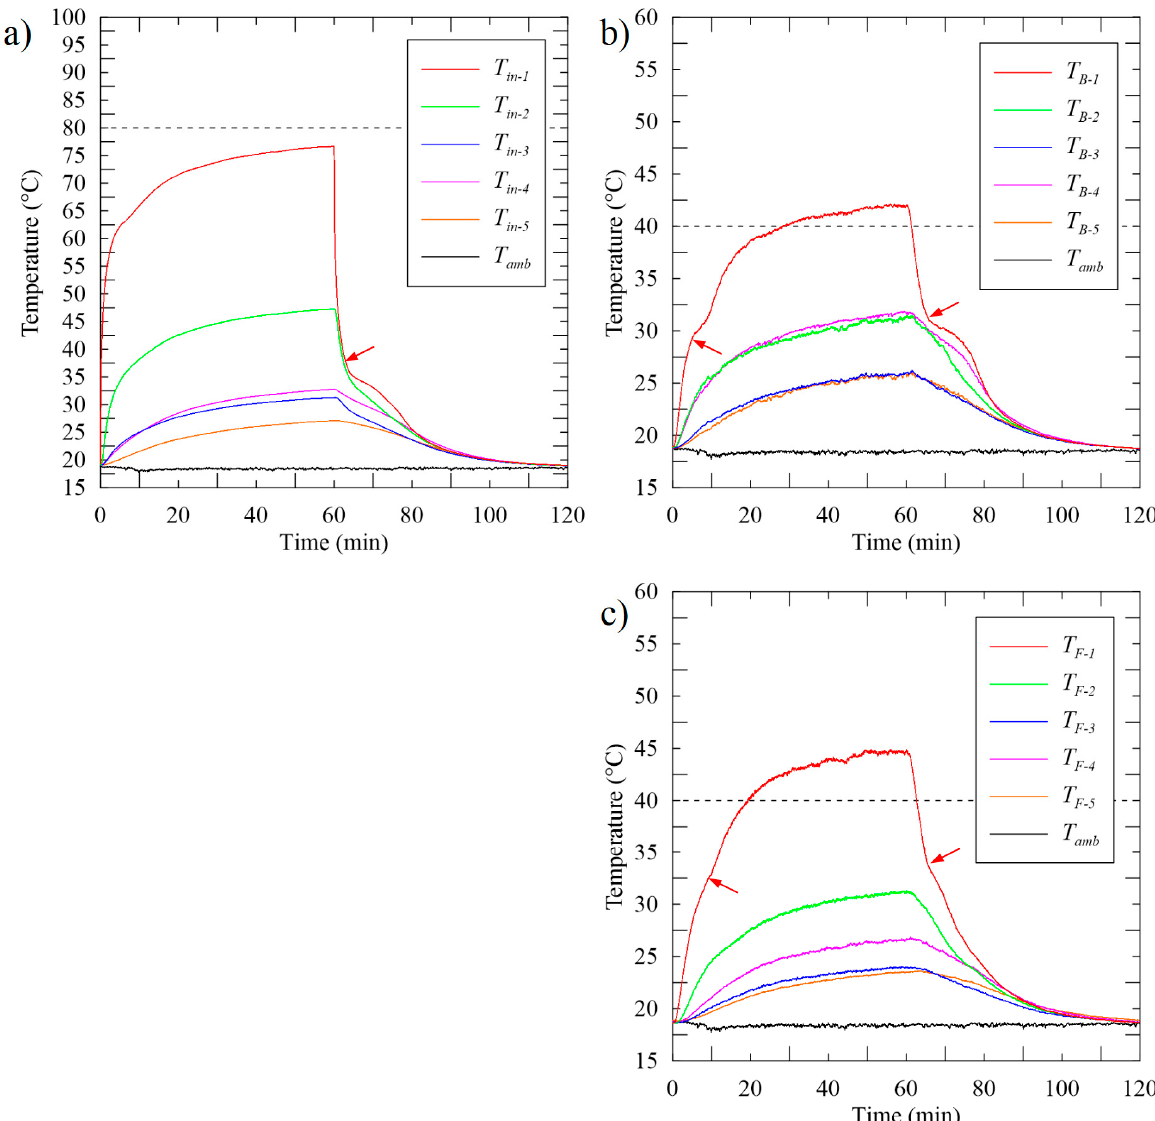
Figure 12. Temperature measurements on the ( a ) inside, ( b ) back cover, and ( c ) display of the mock tablet with a LHTES, a heat spreader, TIM, and a heat generation rate of 7 W (the dashed line represents the relevant temperature limit). Arrows indicate inflection points (see text for discussion).